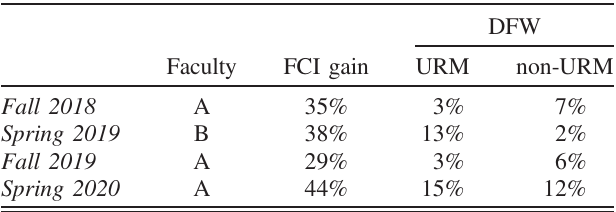
TABLE I. Student FCI and student DFW rates for sections implementing the IPLP model: Fall 2018 (35 URM, 45 non-URM students), Spring 2019 (30 URM, 50 non-URM students), Fall 2019 (33 URM, 49 non-URM), Spring 2020 (34 URM, 43 non- URM). The specific faculty member is indicated as Faculty A or B.